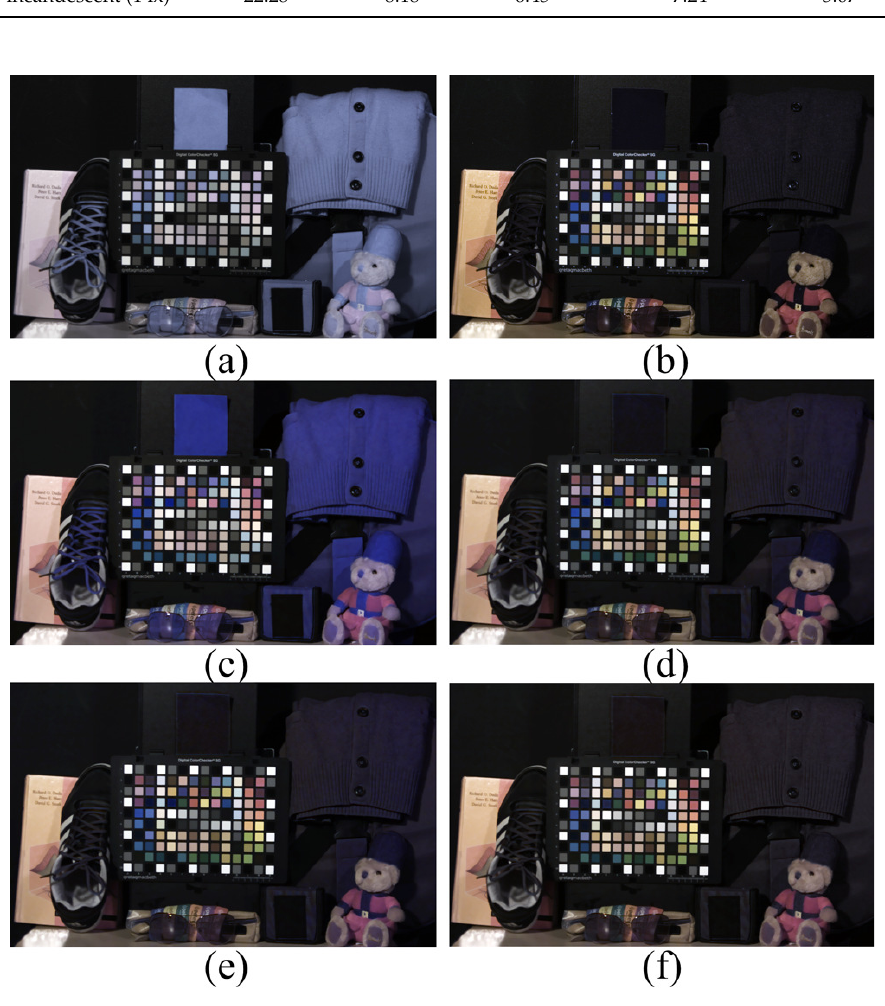
Figure 22. Experimental results under sodium lamp (1 lx) ( a ) Input image; ( b ) optical filtered visible band image; ( c ) 3 × 3 CCM; ( d ) 3 × 4 CCM; ( e ) root-polynomial mapping; ( f ) proposed